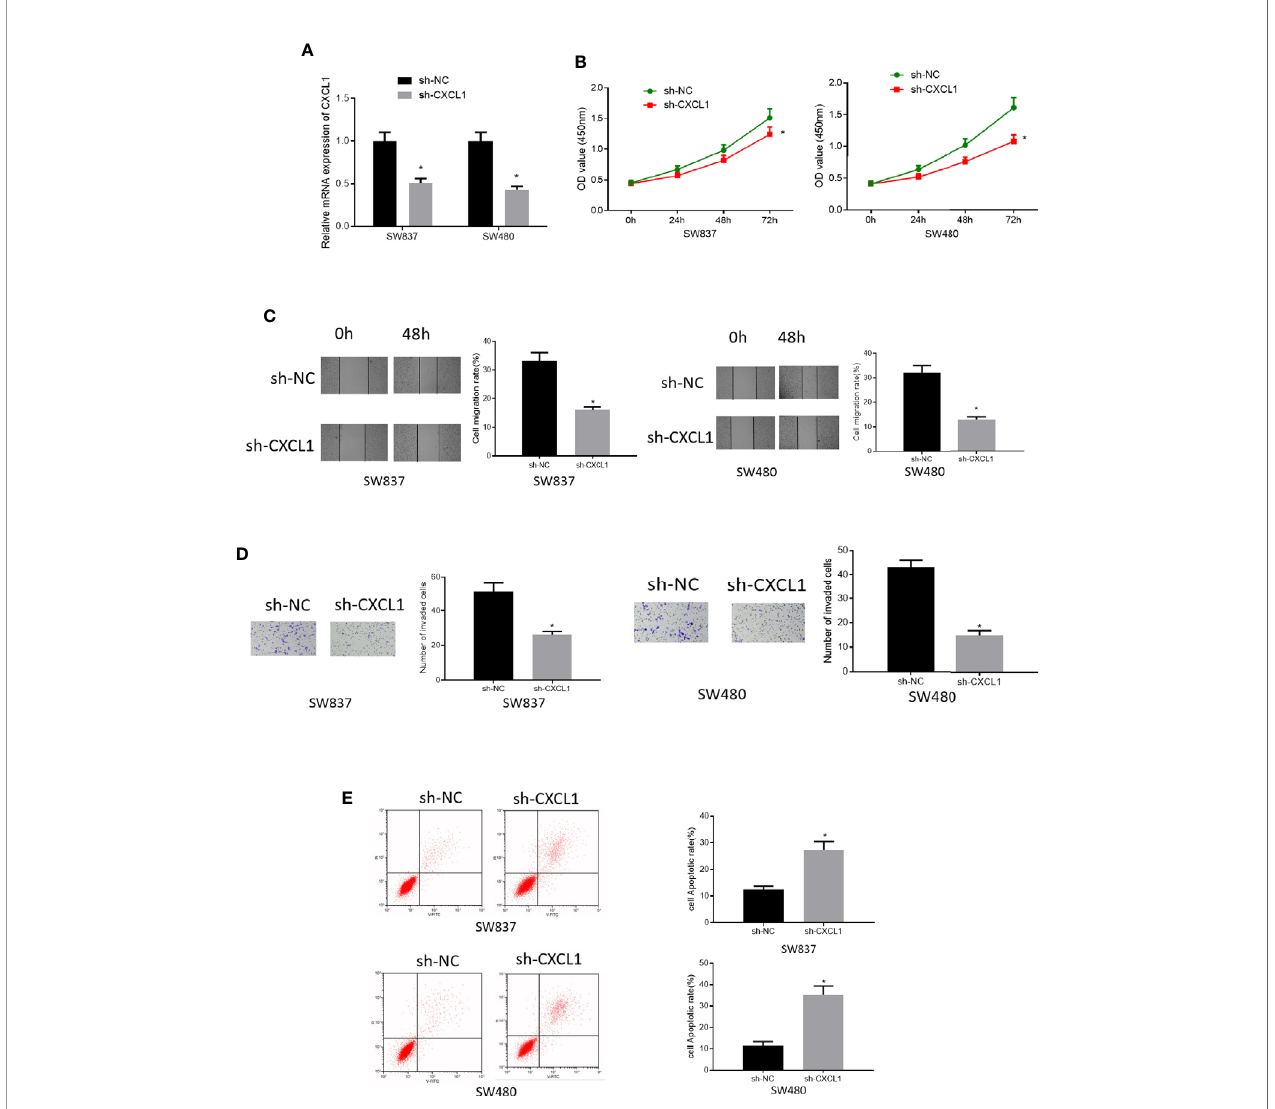
FIGURE 3 | Silencing CXCL1 inhibits cell proliferation, migration, invasion and promotes cell apoptosis of CRC. (A) qRT-PCR results showed the relative expression of CXCL1 after sh-CXCL1 and sh-NC were respectively transfected into SW837 and SW480 cells, (B) CCK-8, (C) wound healing assay, (D) Transwell invasion assay (100×), and (E) fl ow cytometry results showed the effect of silenced CXCL1 on proliferation, migration, invasion, and apoptosis of transfected cells (* p <